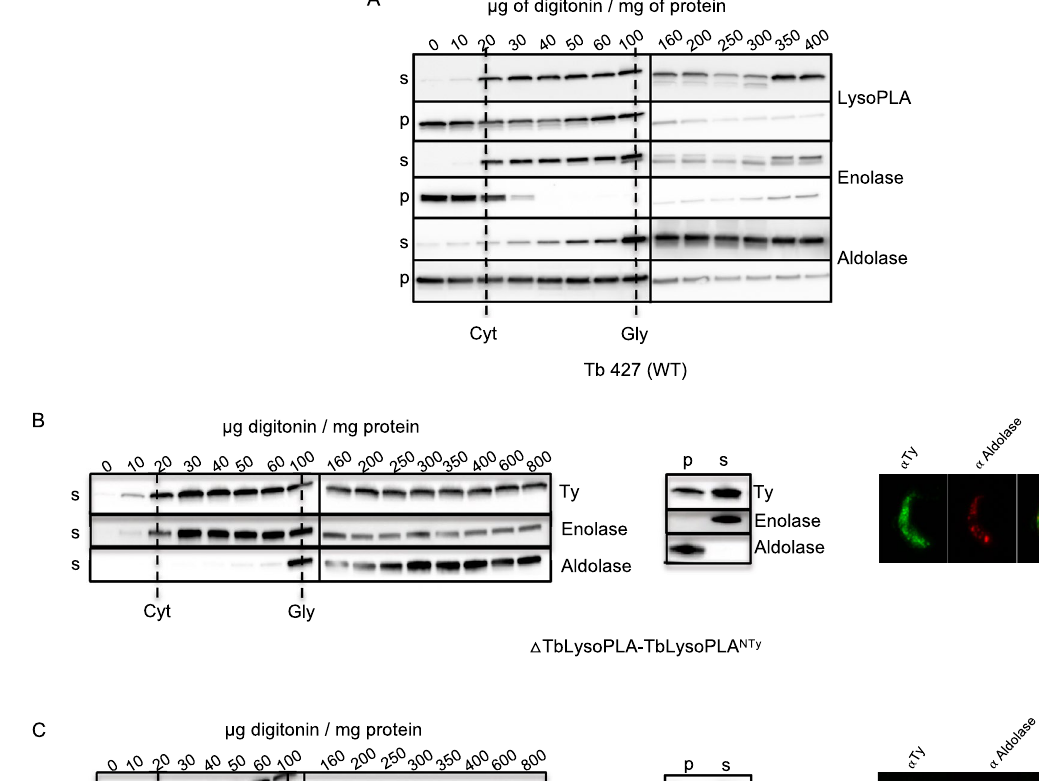
Figure 4. Subcellular distribution of TbLysoPLA in bloodstream forms. Digitonin titration (left of B , C and D ): Western blot analysis of the supernatant (s) and pellet (p) fractions from cells incubated with 0.01–0.4 mg digitonin/mg protein in STE buffer containing 150 mM NaCl. The digitonin concentration required to release cytosolic (cyt) and glycosomal (gly) marker proteins are indicated by vertical dash line. TbLysoPLA was detected with specific anti-TbLysoPLA in ( A ) and anti-Ty in ( B ), ( C ) and ( D ). For technical reasons two gels/ membranes were needed to analyse the whole set of samples. The Vertical line between 100 and 160 indicates a delimitation between two different membranes. Hypotonic lysis (middle of B , C and D ): Western blot analysis of supernatant (s) and pellet (p) fractions from cells incubated with hypotonic buffer. Anti-Ty was used for detection of TbLysoPLA. Immunofluorescence Assay (IFA; right of B , C and D ). Cells were stained with monoclonal mouse anti-Ty (Fluorescein channel) and rabbit anti-Aldolase (Alexa 568 channel). Nucleus and kinetoplast are stained with DAPI. Anti-Ty was used for detection of